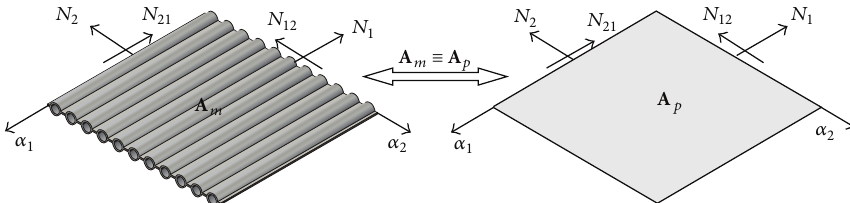
Figure 1: Section forces in the membrane wall, that is, the equivalent orthotropic plate, with the membrane stiffness of membrane wall A 𝑚 equivalent to the membrane stiffness of orthotropic plate A 𝑝 .